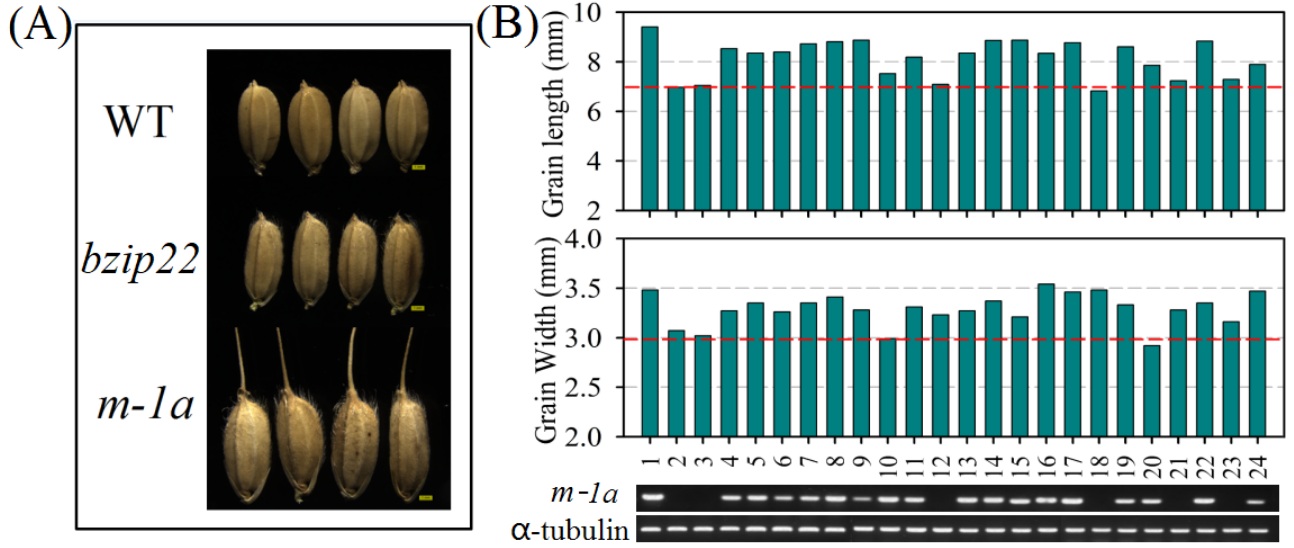
Figure 1. Phenotypes of transgenic rice plants. ( A ) Seed morphologies of T 1 transgenic rice. WT = wild-type plants (‘Zhonghua 11’), bzip22 = normal transgenic rice plants of ZmbZIP22 . Bar = 1 mm. ( B ) Co-segregation analysis of the grain size using T 2 m-1a transgenic seeds. 1–24 = T 2 m-1a transgenic seeds. Red dotted lines represent the size mean of wide-type seeds.